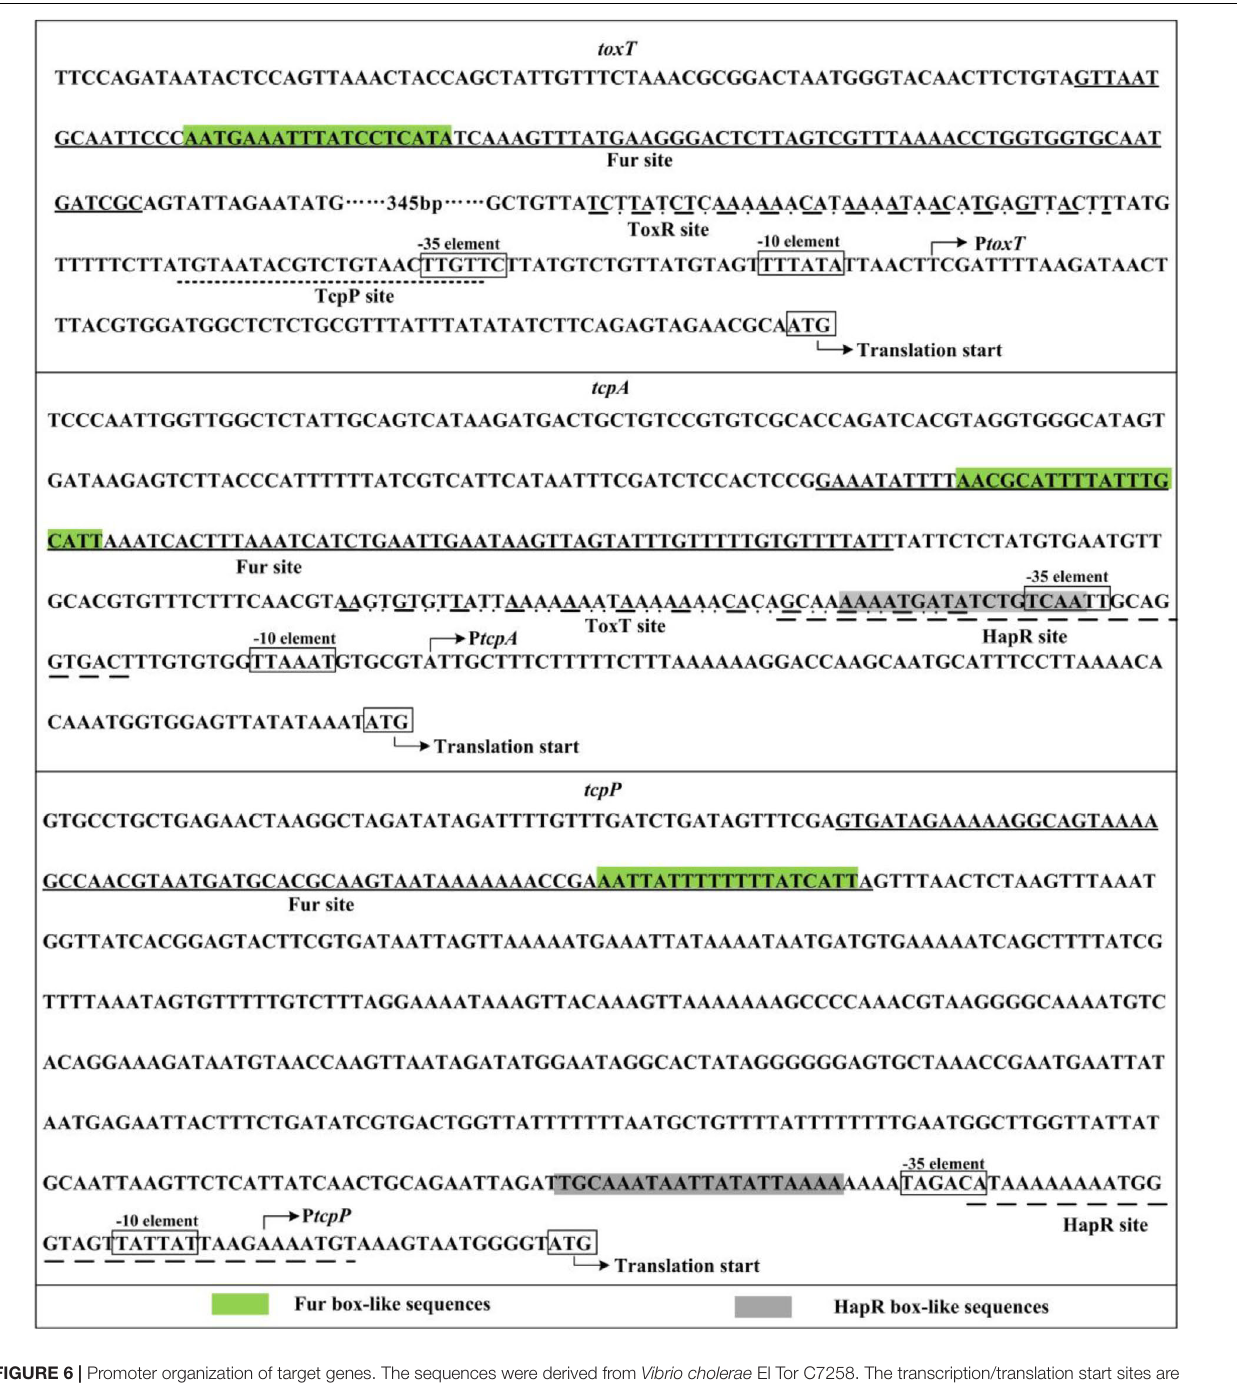
FIGURE 6 | Promoter organization of target genes. The sequences were derived from Vibrio cholerae El Tor C7258. The transcription/translation start sites are indicated by bent arrows. The –10 and –35 elements are enclosed in boxes. The binding sites of ToxR and TcpP identified by DNase I digestion were previously reported by Krukonis et al. (2000). The sequence protected by ToxT in the promoter DNA region of tcpA was identified by Yu and DiRita (2002) and Withey and DiRita (2006). The Fur sites are underlined with solid lines, whereas the HapR sites are underlined with broken